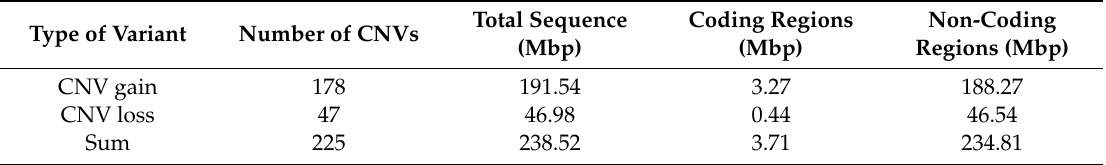
Table 2. Data shows number of identified CNVs sorted by the type of variant and number of Mega base pairs (Mbp) attributed to specific genomic